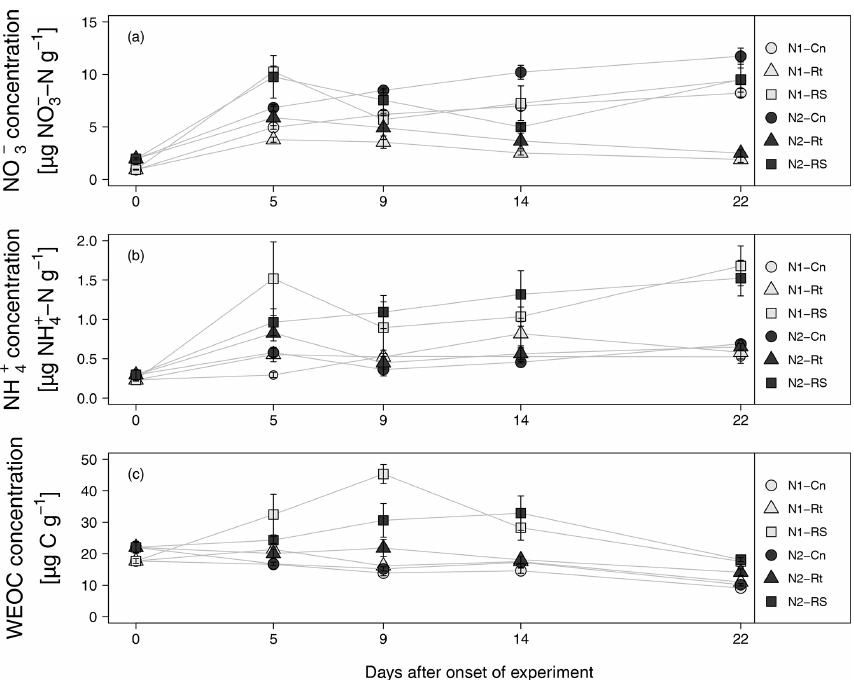
Figure 4. (a–c) NO − , WEOC, and NH + concentration from soils with two N levels (N1, N2) after incorporation of maize root litter (Rt), 3 4 maize root + shoot litter (RS), and control (Cn) without litter. Error bars show the standard error of mean values ( n = 4) (day 0: n = 3). When not visible, error bars are smaller than the symbols.